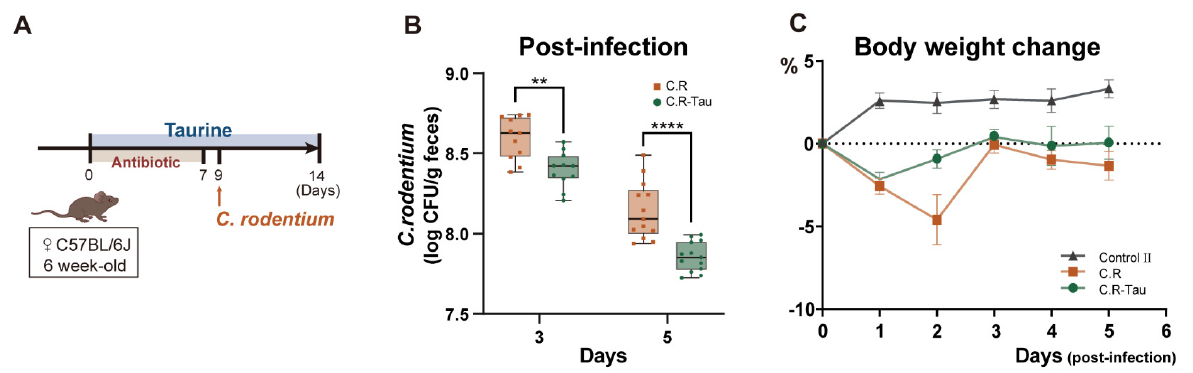
Figure 7. Taurine supplementation enhances colonization resistance. ( A ) Schematic diagram of the experimental design. ( B ) The fecal burden of C. rodentium 3 − and 5 − days post − infection. ( C ) Weight change from baseline (weight at 1 day before infection). Data are presented as the means ± SEM. ** p < 0.01 and **** p < 0.0001 by unpaired two-tailed Student’s t − test.